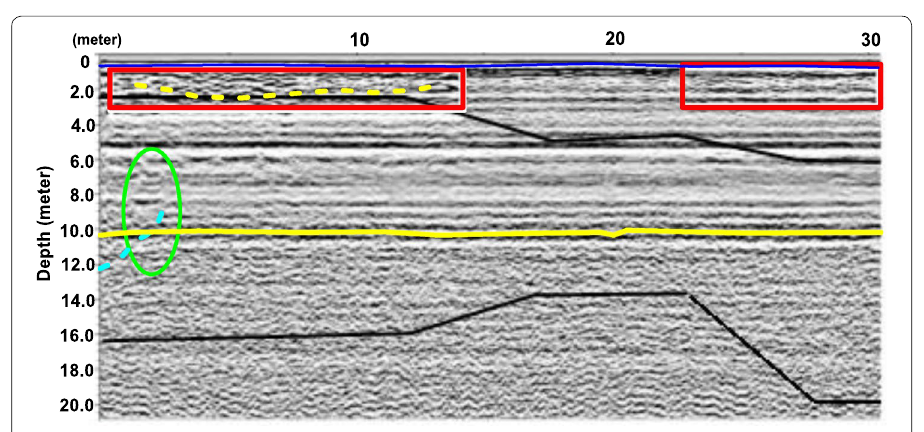
Fig. 18 GPR profile